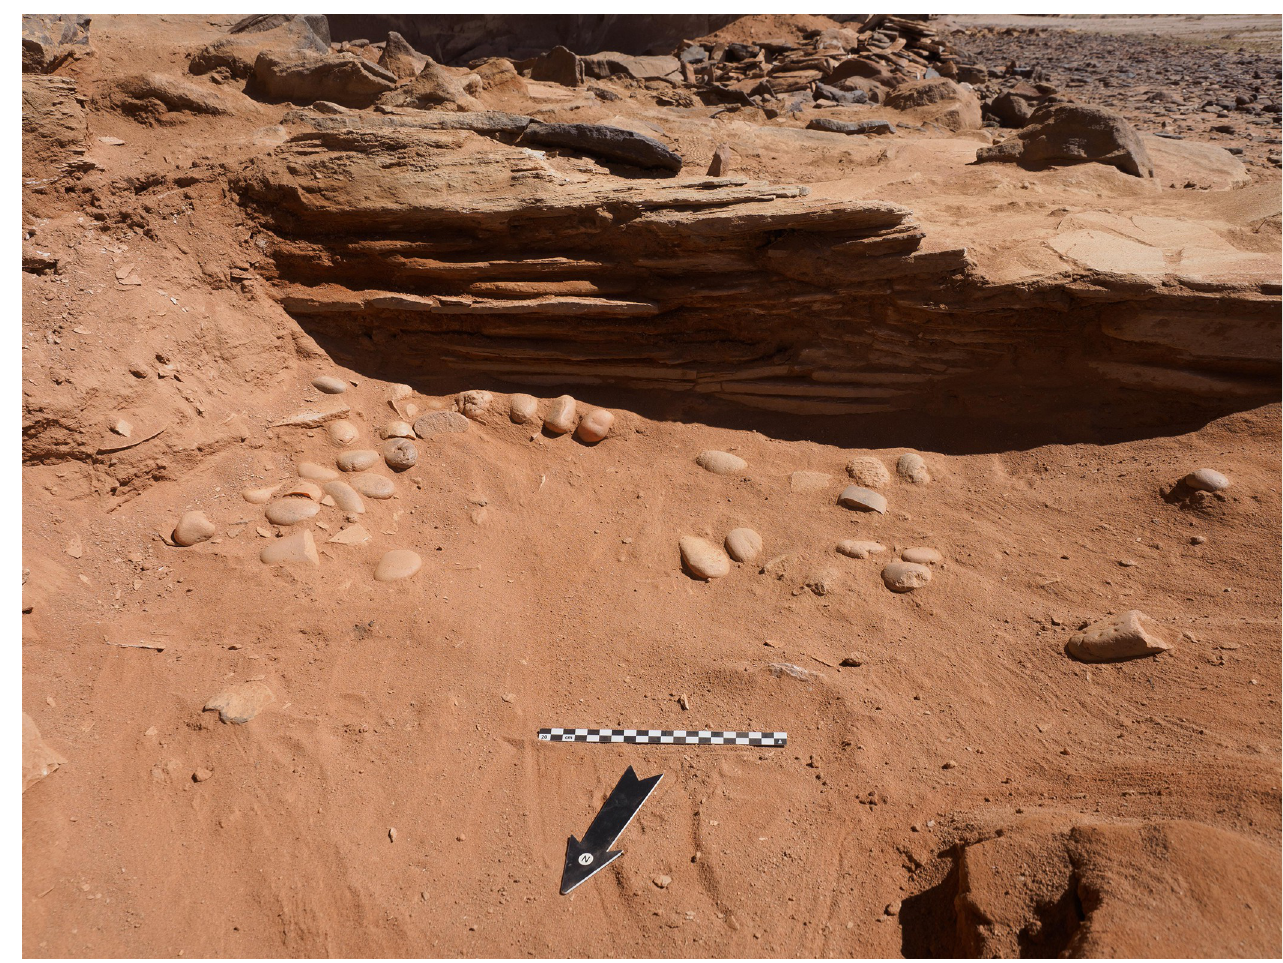
Fig 21. Riverstone surface associated with courtyard, further pebbles were set within the